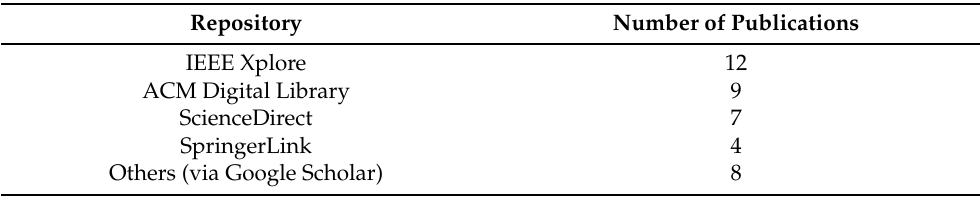
Table 1. Numbers of publications selected from repositories and search